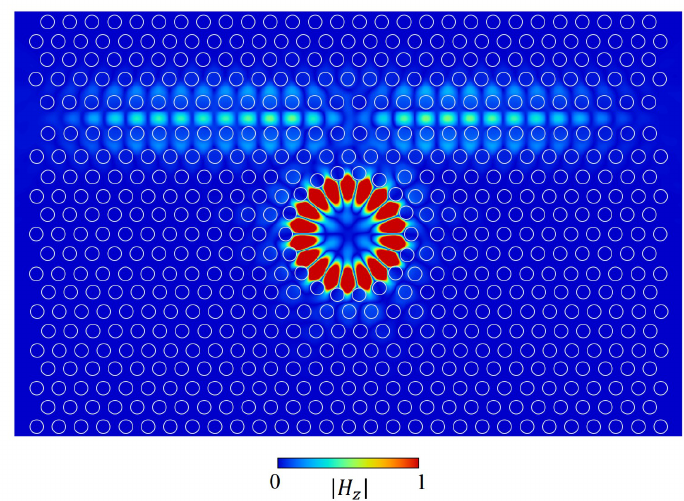
Figure 2. Magnetic field intensity ( | H z | ) distribution of Circular Defect (CirD) lasers. Circles represent air